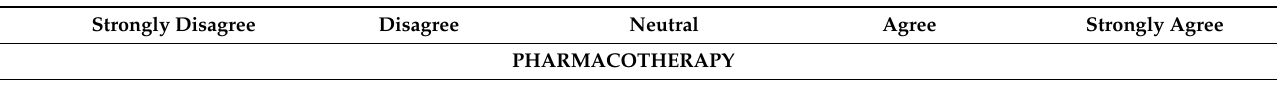
Table 1. Inter-specialty response variability among surveyed physicians (A—anaesthesiologists, C—cardiologists, G—gynaecologists).